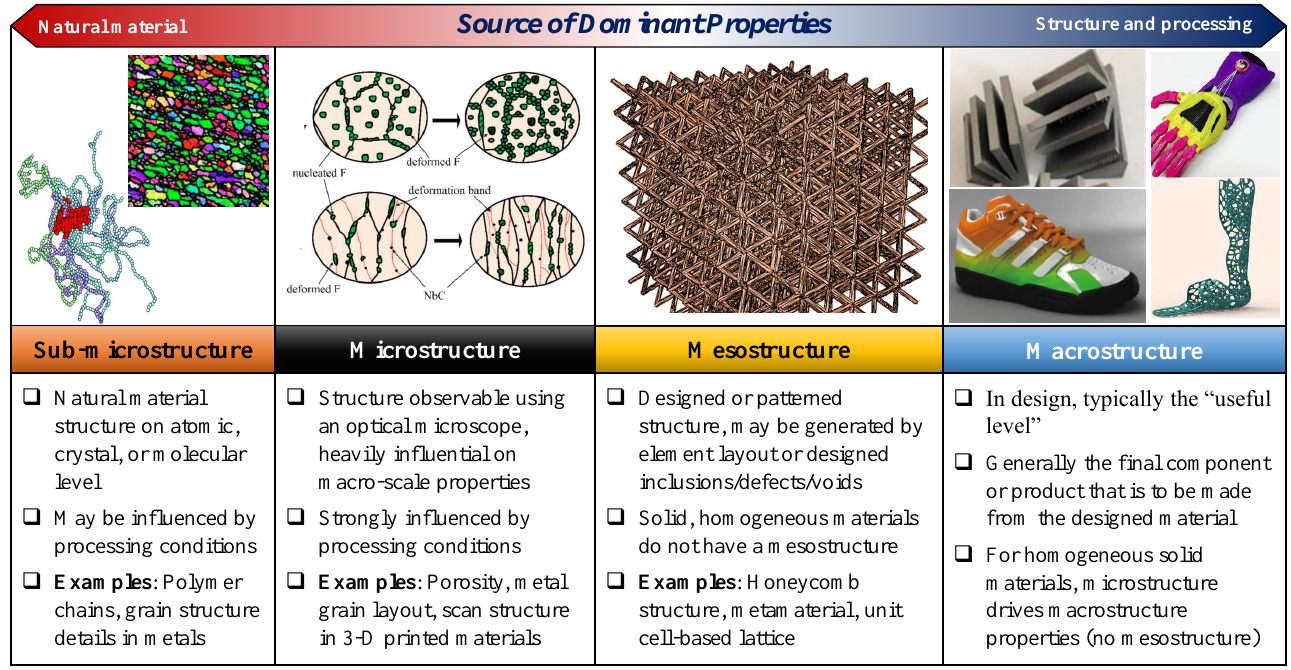
Figure 3. Design scales for materials and parts/products referred to throughout this paper. The mesostructure level will be the most often used and discussed. This chart shows examples of non-polymer materials for completeness, but it should be noted that nearly all FDM materials are thermoplastic